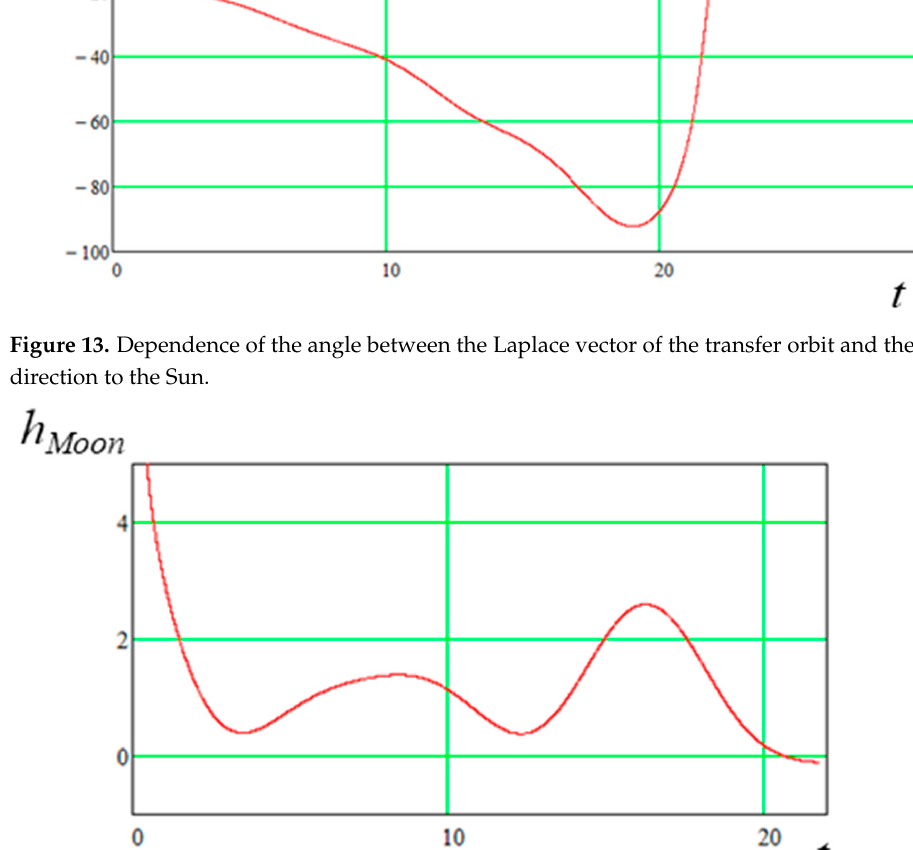
Figure 15. Section of the flight trajectory with a negative value of selenocentric energy. Shown with blue crosses; it can be seen that the energy becomes negative at a fairly significant distance from the moon. From Figures 14 and 15 it follows that the selenocentric energy constant becomes negative long before the SC enters the Moon’s gravity sphere. For the numerical solution of the considered optimization problem of the second stage, it is quite natural to use the corresponding solution of the first stage problem as an initial approximation. However, it is important to note here that the addition of a con- straint of the form (16) significantly increases the sensitivity of the problem under consid- eration to variations in its unknown parameters. Thus, the restriction on reaching a given altitude above the surface of the Moon turns out to be quite “rigid”; this is due to the very strong influence of disturbances acting on the trajectory of the selenocentric motion of the